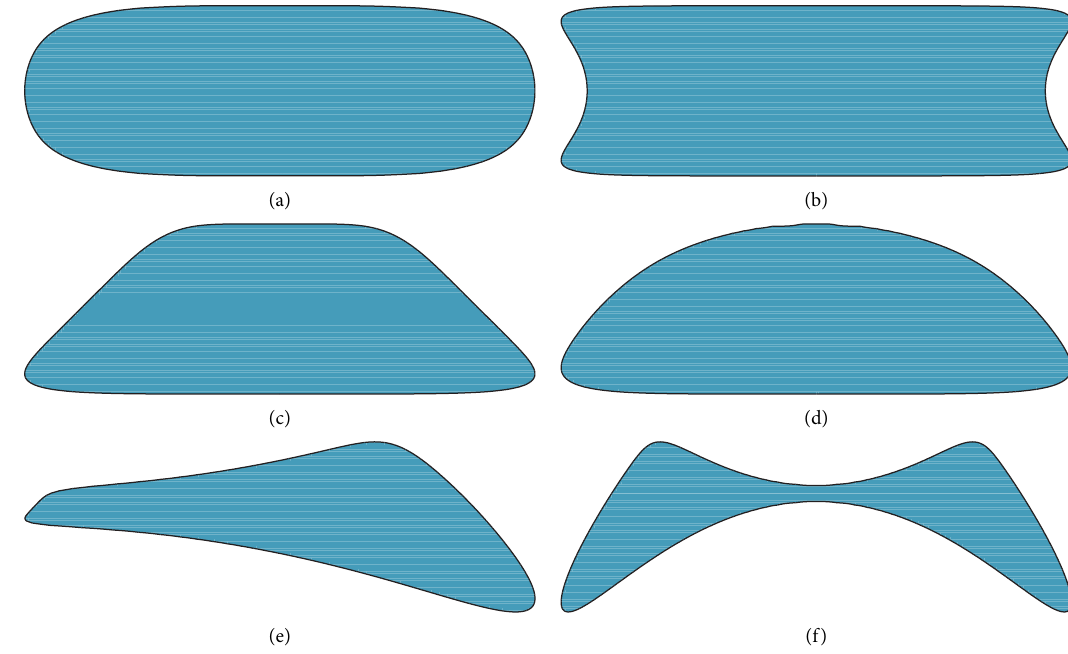
Figure 5: Geometry description of components with different